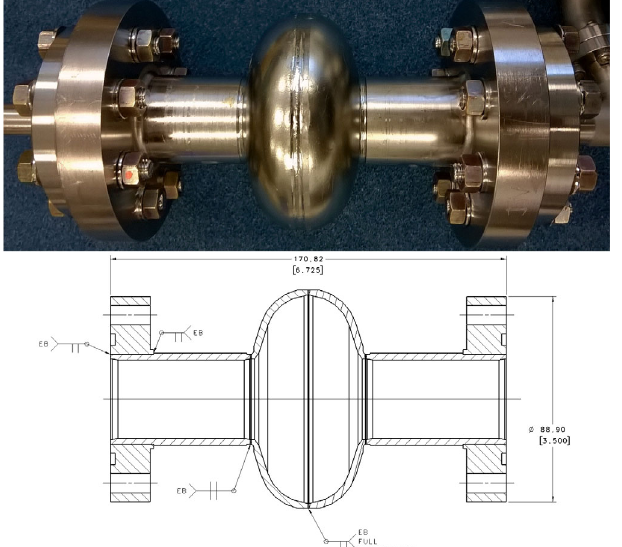
FIG. 1. The photo of FH3A assembled for testing is shown in the top. The sketch of the cavity shape, which is the TESLA long end half cell [13] scaled to 3 GHz, is shown in the bottom.